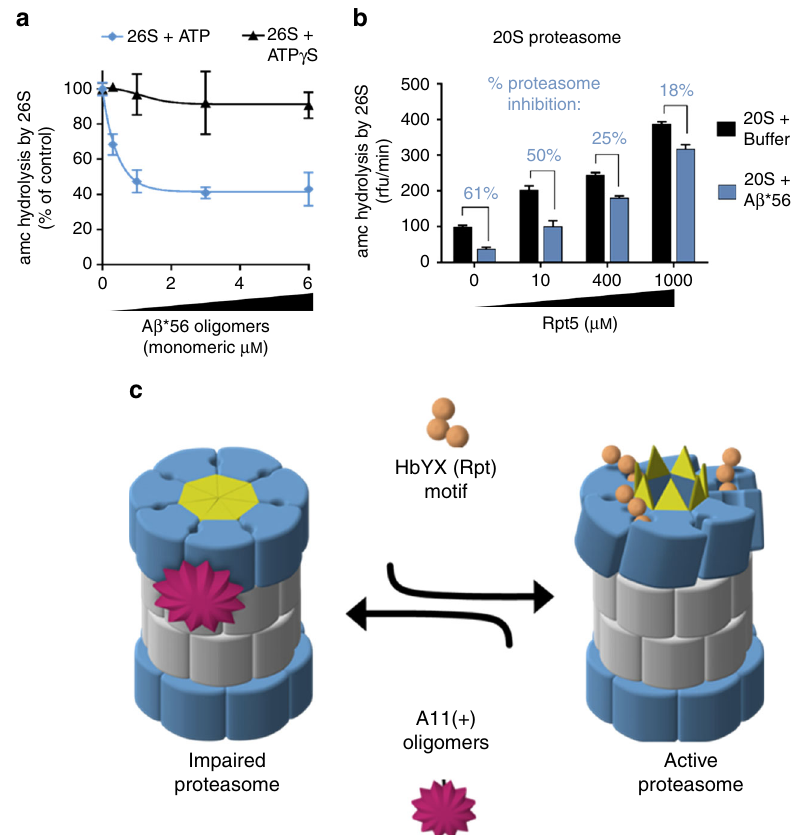
Fig. 6 HbYX-dependent 20S gate opening counteracts inhibition by A β *56 oligomers. a Mammalian 26S proteasome activity (LLVY-amc hydrolysis, rfu/ min) with 2 mM ATP or 10 μ M ATP γ S. A β *56 titration up to 6 μ M. b 20S proteasome activity (nLPnLD-amc hydrolysis, rfu/min) with RPT5 peptide titration, with and without A β *56 (0.5 μ M). c Schematic depicting our working model for proteasome inhibition by A11( + ) oligomers (see text for details). The concentration of A β *56 oligomers is calculated based on A β monomeric peptide mass (4.5 kDa). All controls contained an equal volume of buffer identical to that of the A β *56 oligomers. The data are representative of three or more independent experiments performed in triplicate. Error